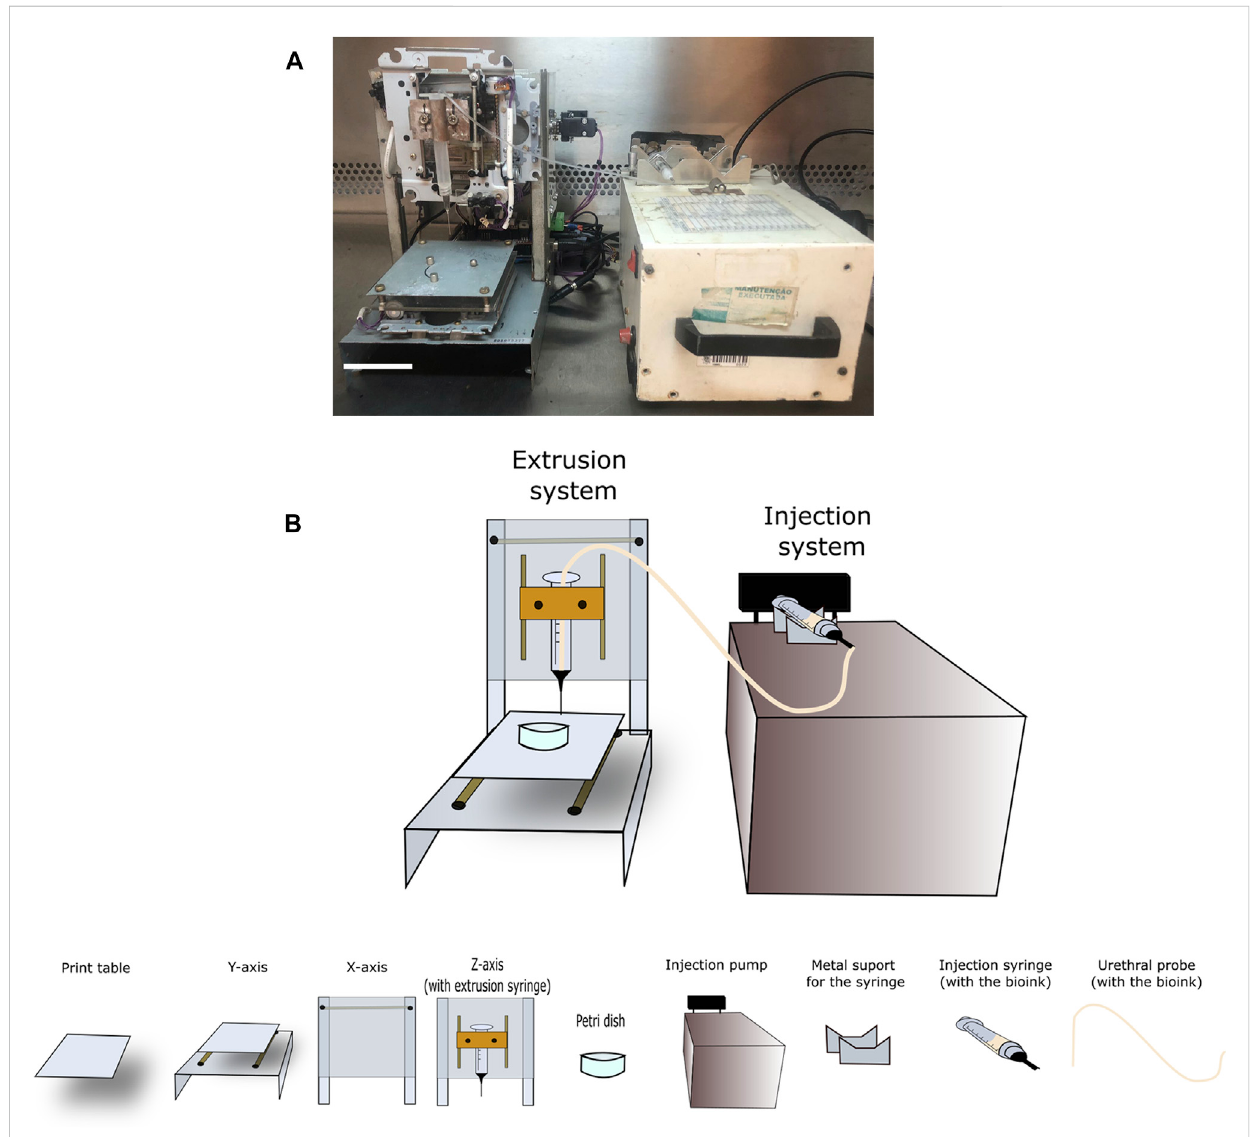
FIGURE 5 Prototype design. (A) Frontalbioprintview indicating all prototype parts,followinga (B) schematic designindicating detailsatthebottom describing the infusion pump, table, and extrusion head, as well as the X, Y, and Z-axes. Scale bar: 3